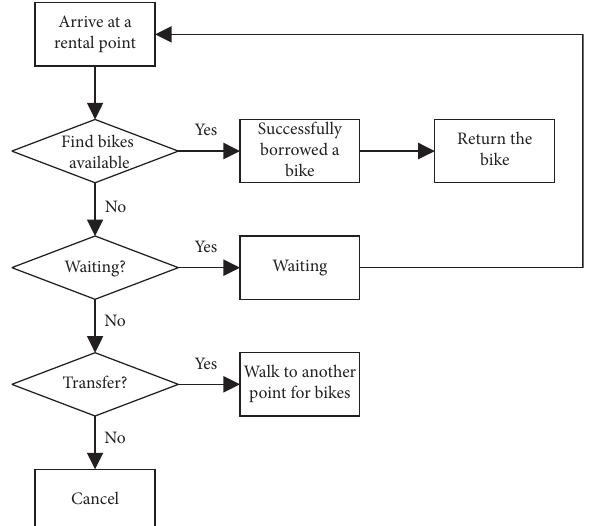
Figure 1: The invalid demand of